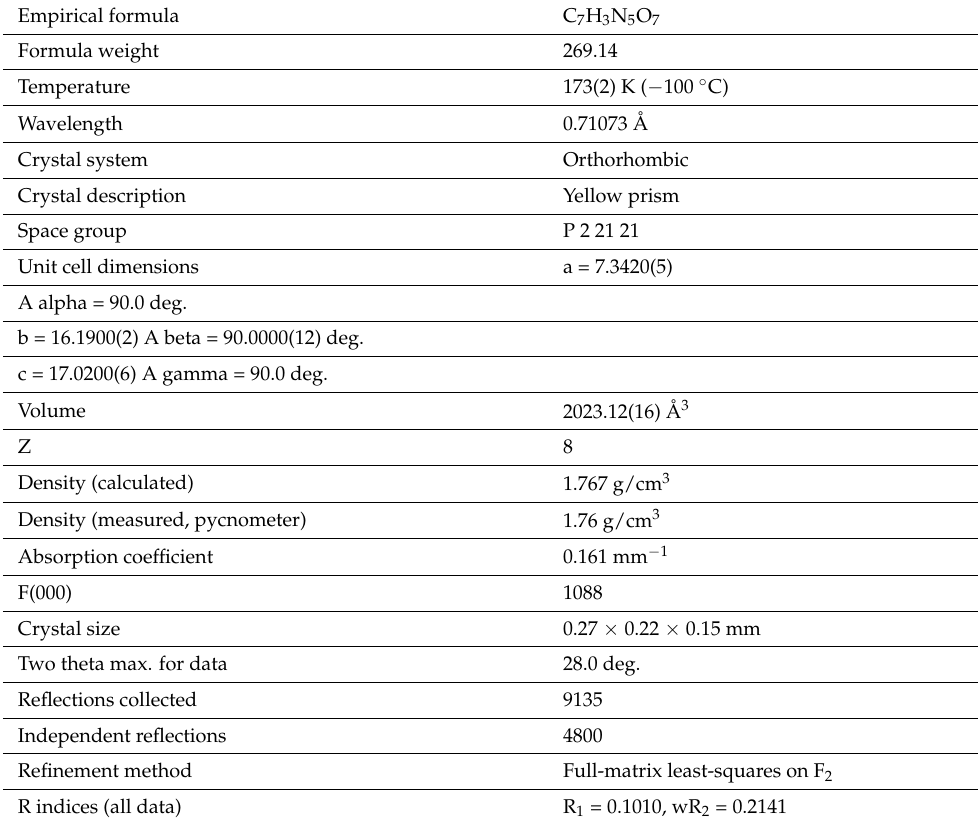
Figure 7. Ortep image at the 50% probability of thermal ellipsoids for (TriNBO)—(the crystal was obtained by growing from the cold solution in 95% HNO 3 ). (CCDC: 1882607). Table 1. The main crystallographic data for TriNBO ( 1 ).